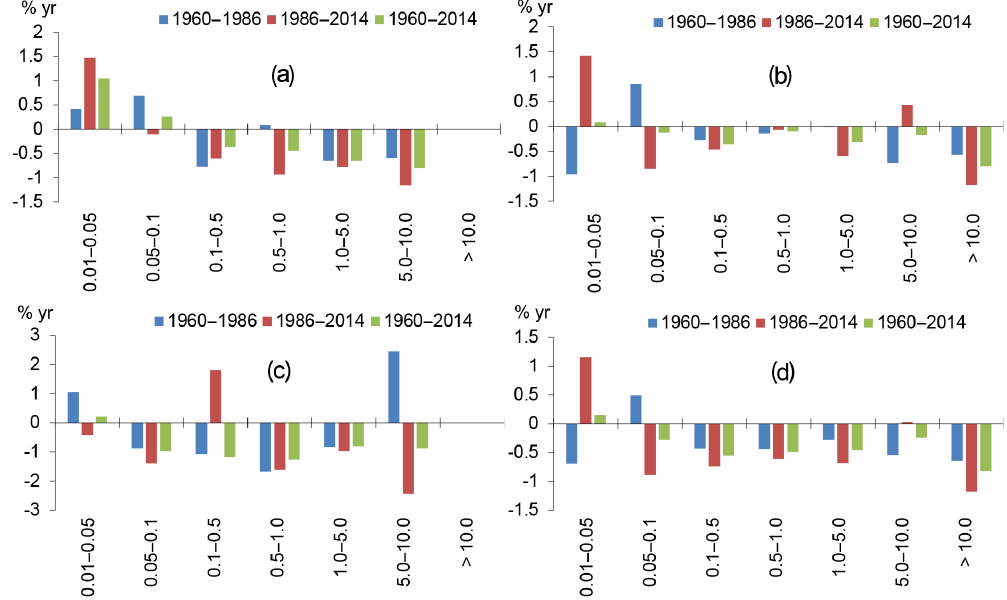
Figure 6. Area change for the seven glacier size classes in the (a) western, (b) central and (c) eastern sections and in (d) the entire Greater Caucasus in 1960–1986, 1986–2014 and 1960–2014.